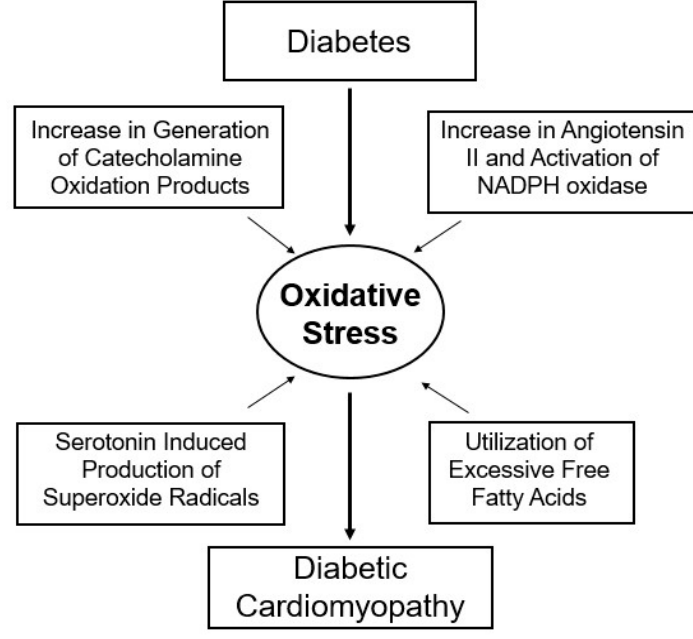
Figure 1. Role of oxidative stress in the pathogenesis of diabetic